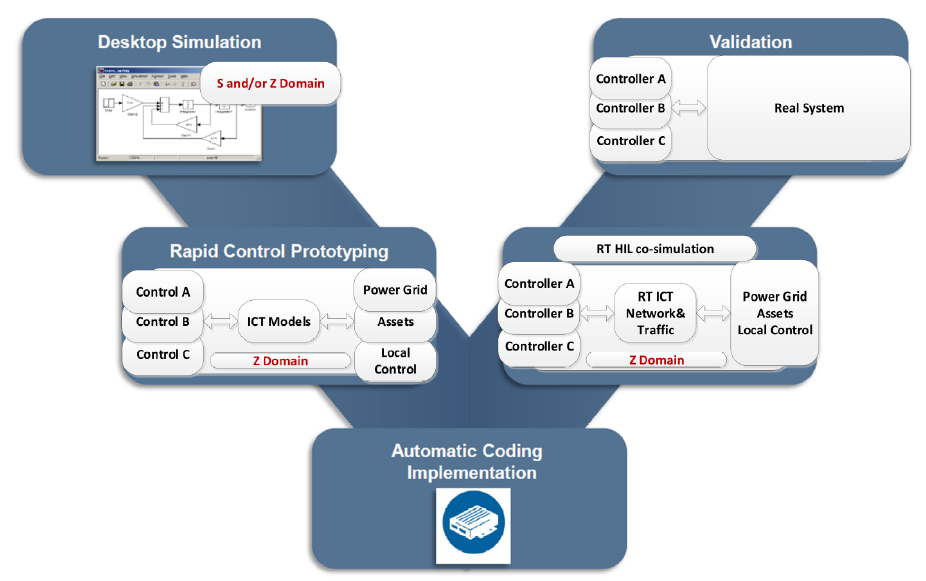
Figure 1. Model-based design approach for power system and SG